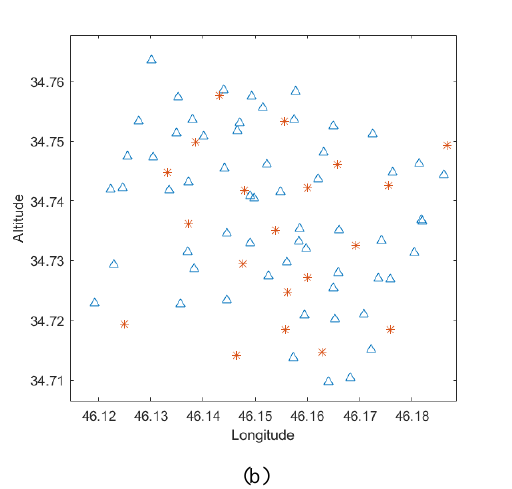
Figure 2. Distribution of GCPs and ICPs: (a) First data-set over Tehran, Iran; (b) Second data-set over Kermanshah, Iran.